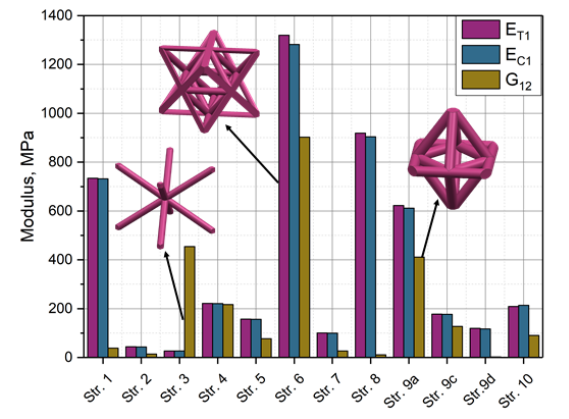
Figure 6. Comparison of the different structures regarding tensile ( E ), compression ( E ) and shear T 1 C 1 Figure 8. Comparison of W for the different lattice ( G 12 ) modulus. structures and for the two